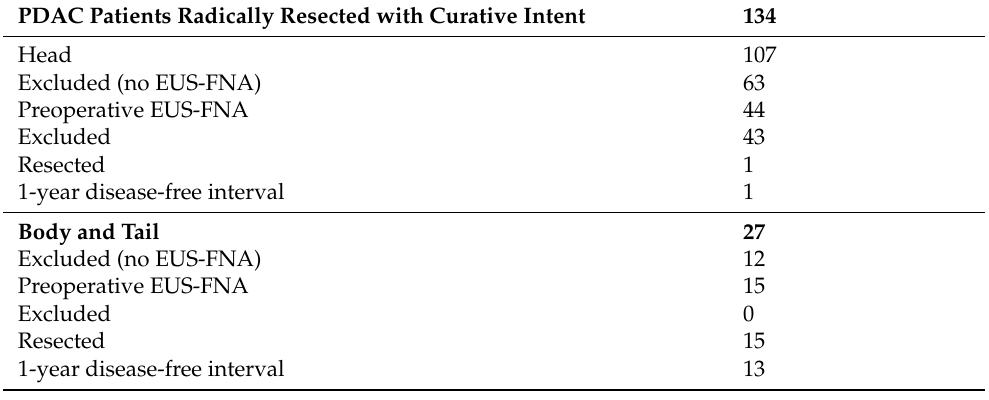
Table 1. Flow chart of PDAC patients included in the study.